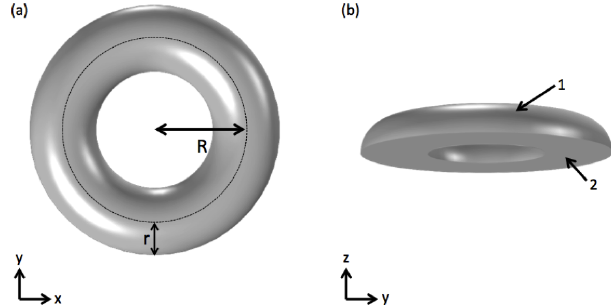
Figure 2. Details of half-torus model used to simulate the flow in experiments: (a) top view, where R and r are the notations used here to describe the dimensions of a half-torus geometry; (b) side view, where surface 1 represents the air–fluid interface, and surface 2 rep- resents the fluid–substrate